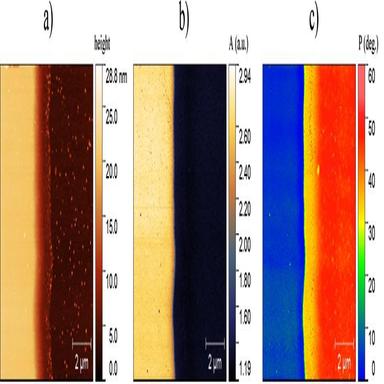
DM sample (Al2O3 as substrate and Pt thin film). Imaging was performed at the edge of the Pt film; (a) AFM topography; (b) s-SNOM 3rd harmonic amplitude; (c) s-SNOM 3rd harmonic phase.